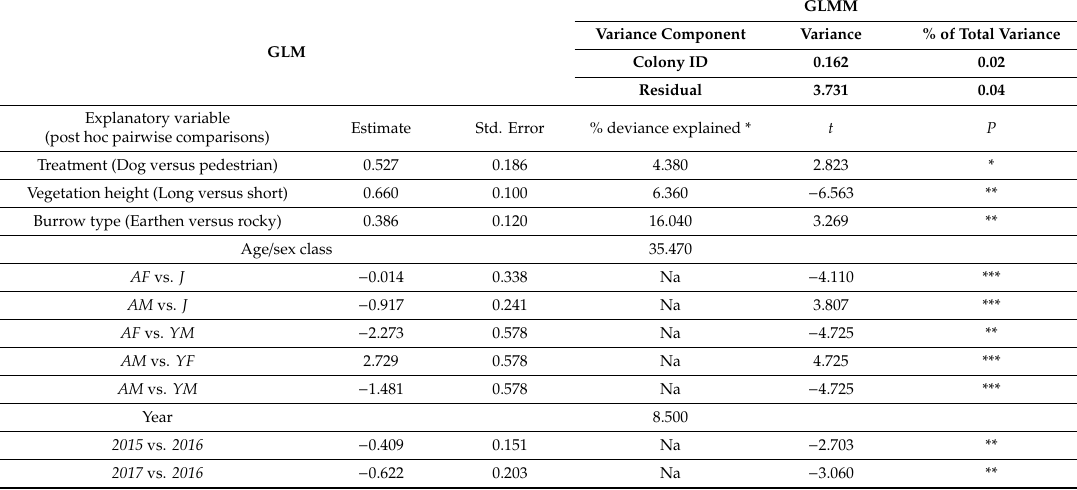
Table 3. Parameter estimates from Maximum Likelihood for significant main e ff ects predicting golden marmot FID within a Generalized Linear (Mixed) Model (GL(M)M) framework. Positive values show greater FID relative to the reference level, which is specified in each case. GLM variables are fixed main e ff ects and GLMM variance components are random e ff ects. Percentage deviance